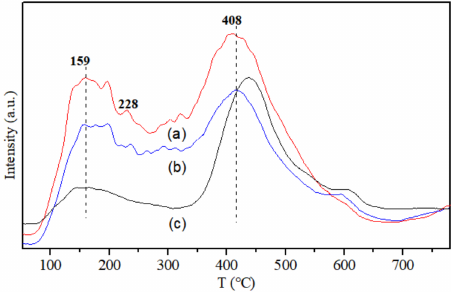
Figure 7. NH 3 -TPD spectra of NT-TBOT ( a ), NT-P25 ( b ), and NT-purchased ( c ), after treatment with hydrogen peroxide.